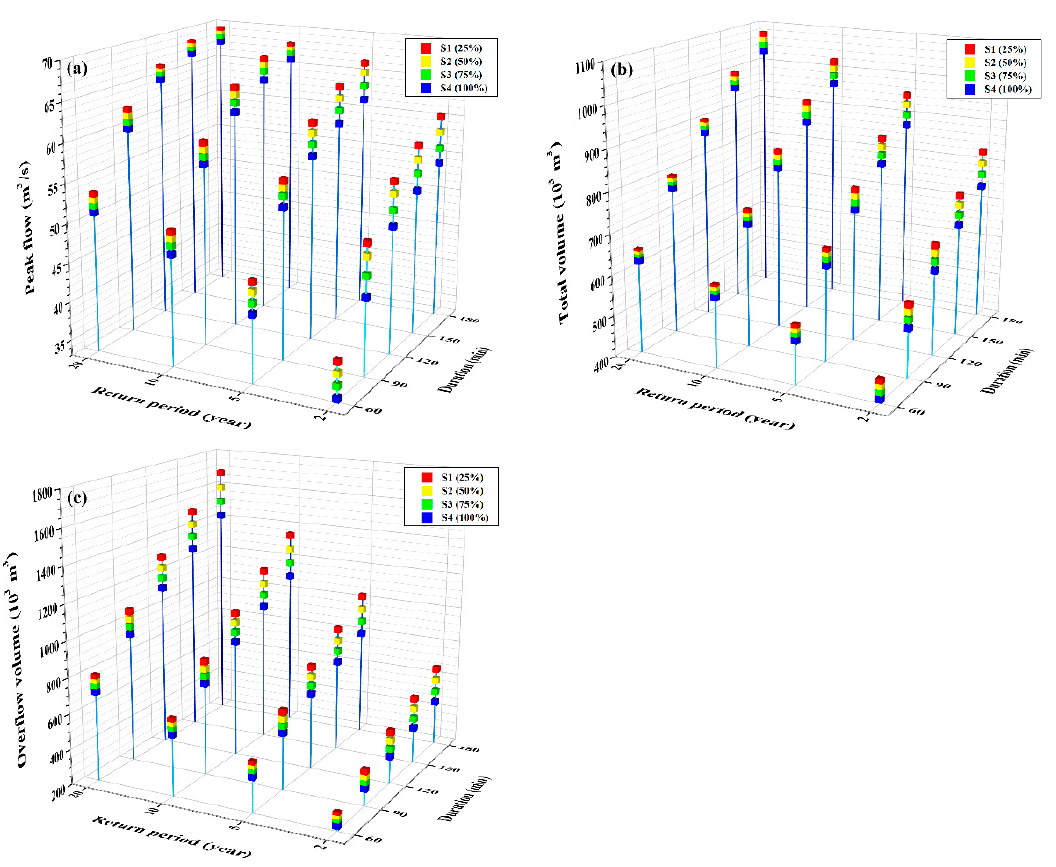
Figure 6. Representations of ( a ) simulated peak flow; ( b ) total volume at outfall, and ( c ) overflow volume at drainage and river networks for all design scenarios.